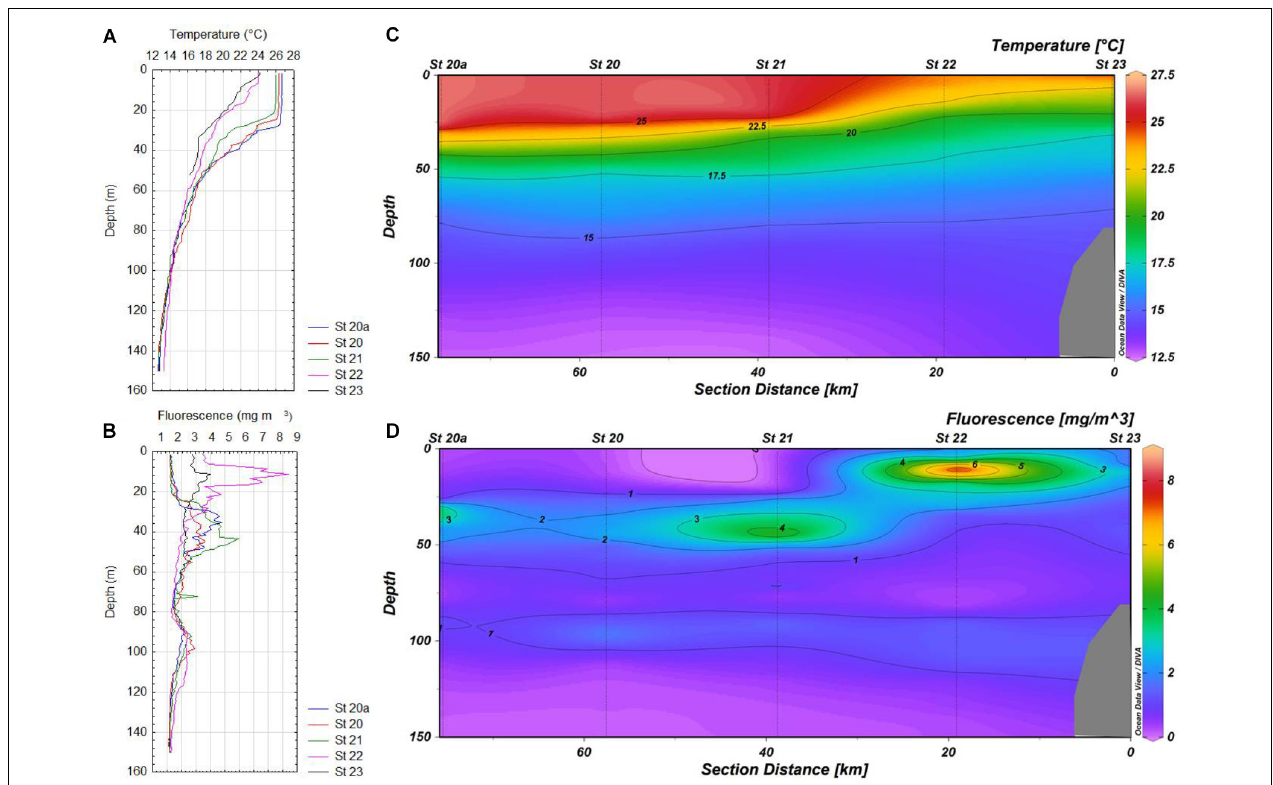
FIGURE 3 | (A,B) Vertical profiles of temperature and in situ fluorescence 20a-23 of the transect in Manzanillo, respectively. (C,D) Maps of the distribution of temperature and in situ fluorescence 20a-23 in Manzanillo,